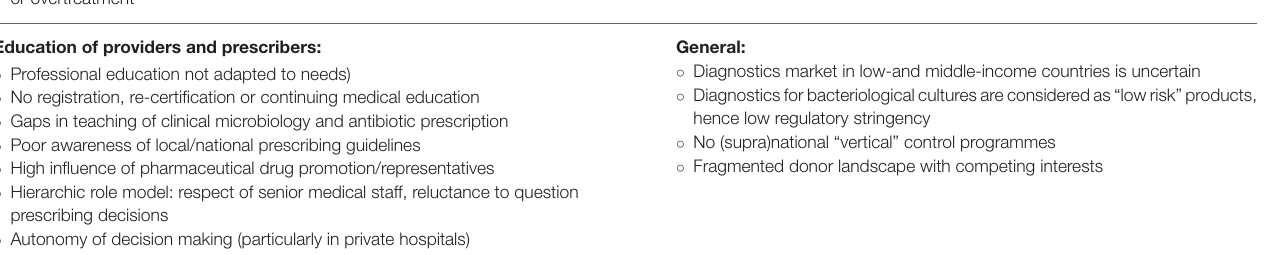
TABLE 1 | Why low-and middle-income countries are hit hardest by antimicrobial resistance: attitudes, practices, and interactions between prescriber, dispenser, patients, diagnostics and health systems, related to human medicine 4 (4, 24–36). Prescriber considerations: ◦ Absence of local surveillance data obscures awareness and knowledge about AMR in the own practice (“No data, no problem”) ◦ Poorly educated and trained in antibiotic use (see below) ◦ In the absence of diagnostic tools, he/she prefers to “cover” the patient for bacterial infections, preferably with broad-spectrum antibiotics ◦ Overuse but also suboptimal use: incorrect diagnosis, incorrect dose, timing, route, frequency and duration, no de-escalation (i.e., using an antibiotic of narrow spectrum based on microbiology reports) ◦ Extended use of antibiotics e.g., in the case of surgical prophylaxis (to “compensate” for inadequate infection control) ◦ The “Knowledge gap”: knowing that antibiotics are not indicated but nevertheless prescribing them (“cough and cold,” watery diarrhea) ◦ Fear of non-respecting and losing the patient when not prescribing antibiotics (taking his/her complaints not serious) ◦ Reliance on (own) clinical diagnosis Dispenser and